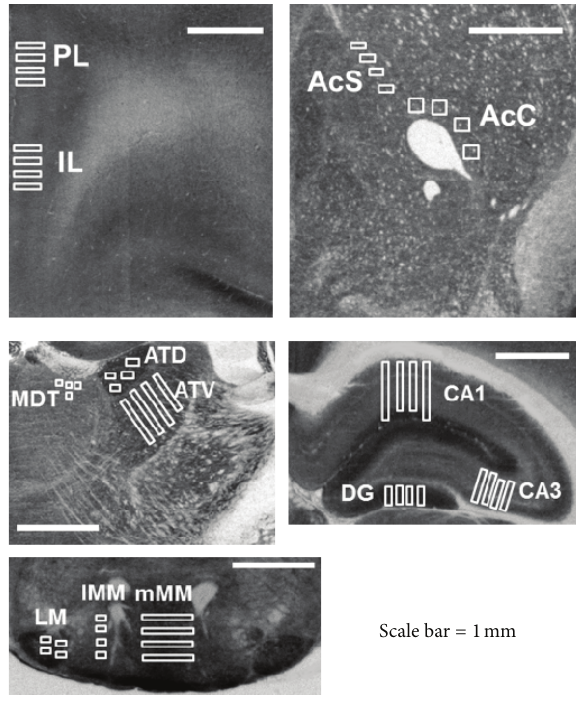
Figure1:Cytochromeoxidase(COx)histochemistryinthesampled regions in which the squares used to take the measures were presented. Prelimbic (PL) and infralimbic (IL) cortex, accumbens core and shell (AcC and AcS), thalamic nuclei (ADT, AVT, and MDT), dorsal hippocampus (CA1, CA3, and DG) and Mammillary nuclei (mMM, lMM, and LM). Scale bar: